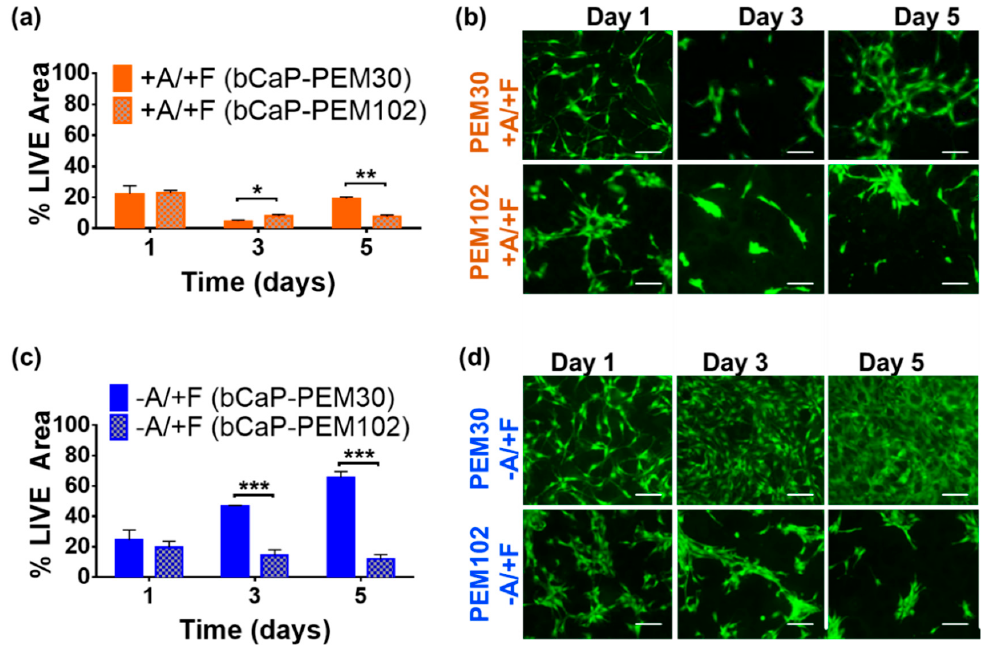
Figure A1. Increasing the number of PEM bilayers: ( a ) percent LIVE ® stained area of MC3T3-E1s cultured on AntiA-bCaP-PEM30-FGF2 as compared to cells cultured on AntiA-bCaP-PEM102-FGF2 (* p < 0.05, ** p < 0.01 and *** p < 0.001); ( b ) fluorescent LIVE ® stained images at one, three, and five days of culture on AntiA-bCaP-PEM30-FGF2 as compared to cells on AntiA-bCaP-PEM102-FGF2; ( c ) percent LIVE ® stained area of MC3T3-E1s cultured on control bCaP-PEM30-FGF2 as compared to cells on bCaP-PEM102-FGF2 (*** p < 0.01); and ( d ) fluorescent LIVE ® stained images at one, three, and five days of culture on bCaP-PEM30-FGF2, as compared to cells cultured on bCaP-PEM102-FGF2. Scale bar = 100 μ m.